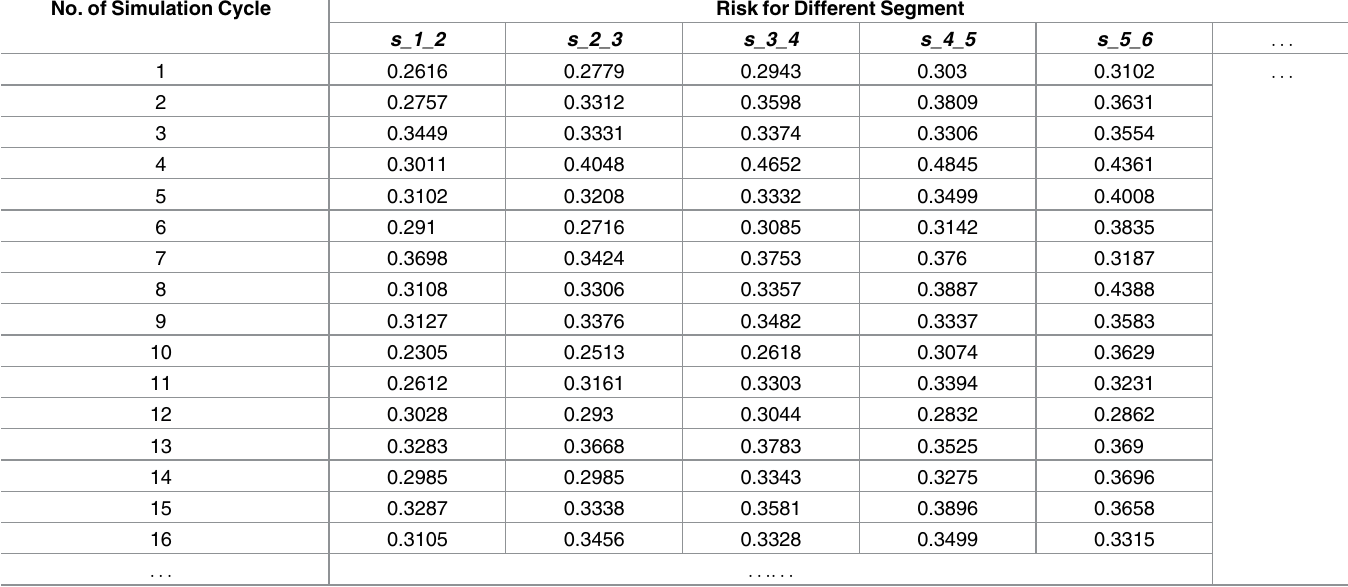
Table 2. Example of data for determining risk thresholds. Risk data from moderate traffic condition(Volume: 1500 veh/h). No. of Simulation